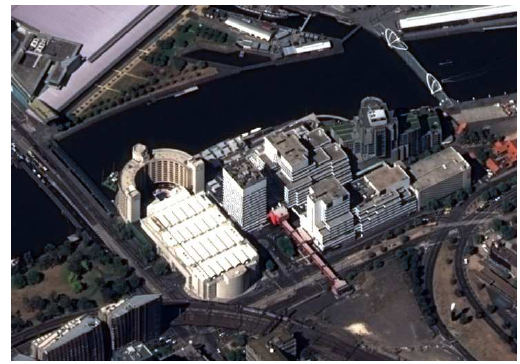
Figure 1. Pleiades-HR image of Melbourne downtown,